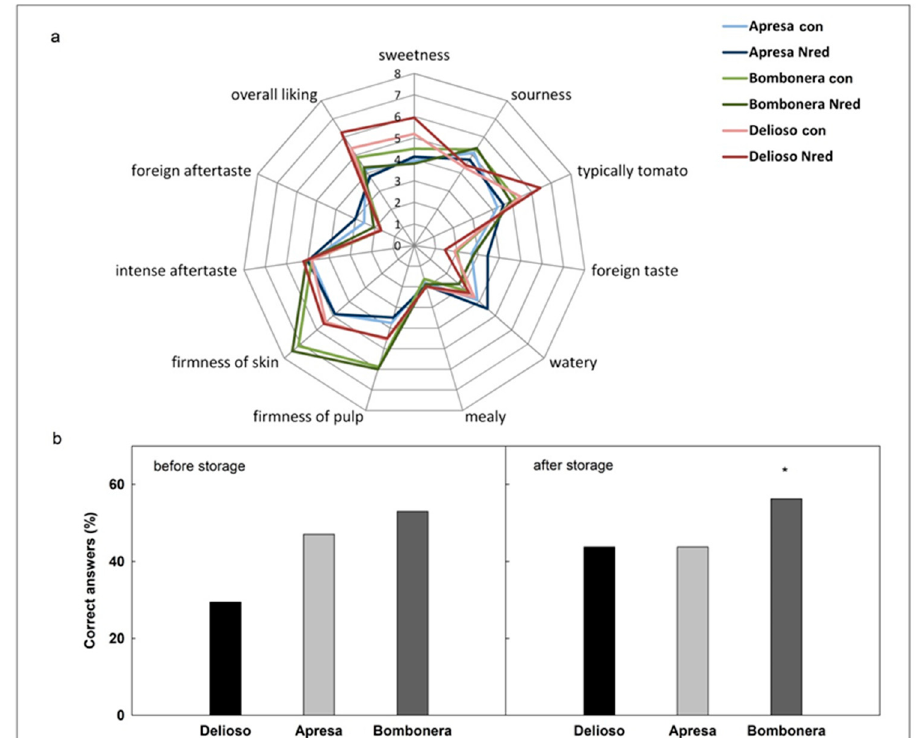
Figure 1. Sensory attributes of three tomato varieties grown with normal (con) and reduced (Nred) N supplies ( a ) and results of triangle tests ( b ). In ( b ), the “correct answers” indicate the relative abundance of correct distinctions between Nred and control samples. Asterisks in ( b ) show significant sensory distinctions between controls and Nred samples. N = 16 for ( a ). N = 16 to 17 for ( b ).